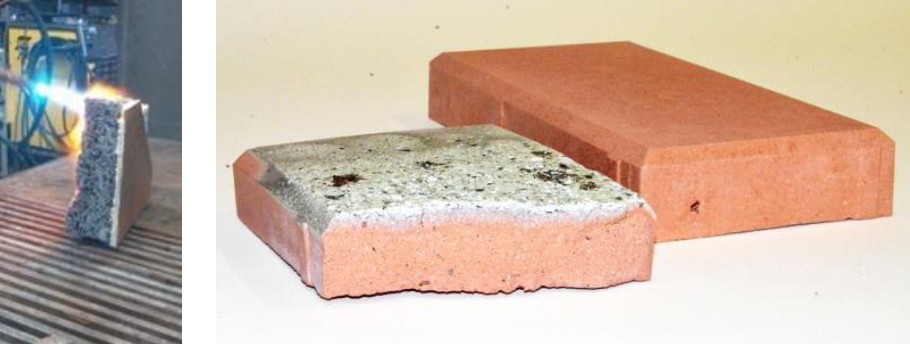
Figure 5. Geopolymer materials tested by oxy-acetylene torch (temperature >3000 °C) (source—own research).